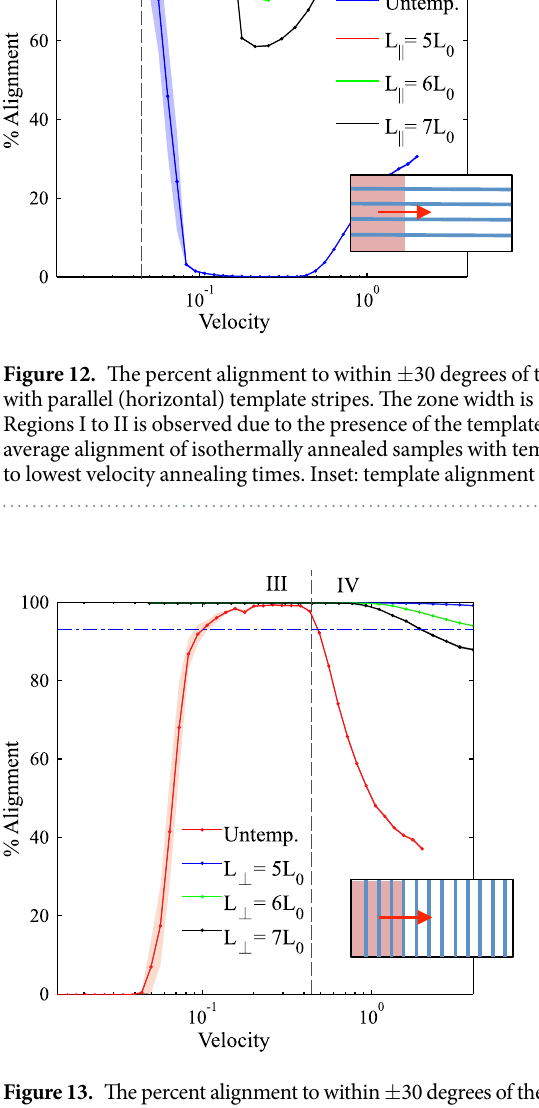
morphologies. We do point out that even our largest zone width is likely an order of magnitude below those formed in CZA experiments. The combination of CZA and chemo-epitaxy can extend the range of velocities at which long-range orien- tational order can be achieved, a result that has implications for the efficient processing of nanopatterned sur- faces. Here, we investigated linear stripe chemical template patterns and found that template stripes oriented perpendicular to the zone velocity resulted in the greatest benefit for improving orientational order. This template orientation takes advantage of the natural tendency of the BCP microdomains to orient perpendicular to the zone velocity at intermediate-to-high velocities. We note that the two-dimensional domains employed in our simulations allowed larger sample regions, however, they prohibited the possibility of out-of-plane microdomain alignment. The results of this study enable the first large-scale analysis of the transition of lamellae orientations from parallel to perpendicular alignment during zone annealing with a wide range of zone velocities and widths,